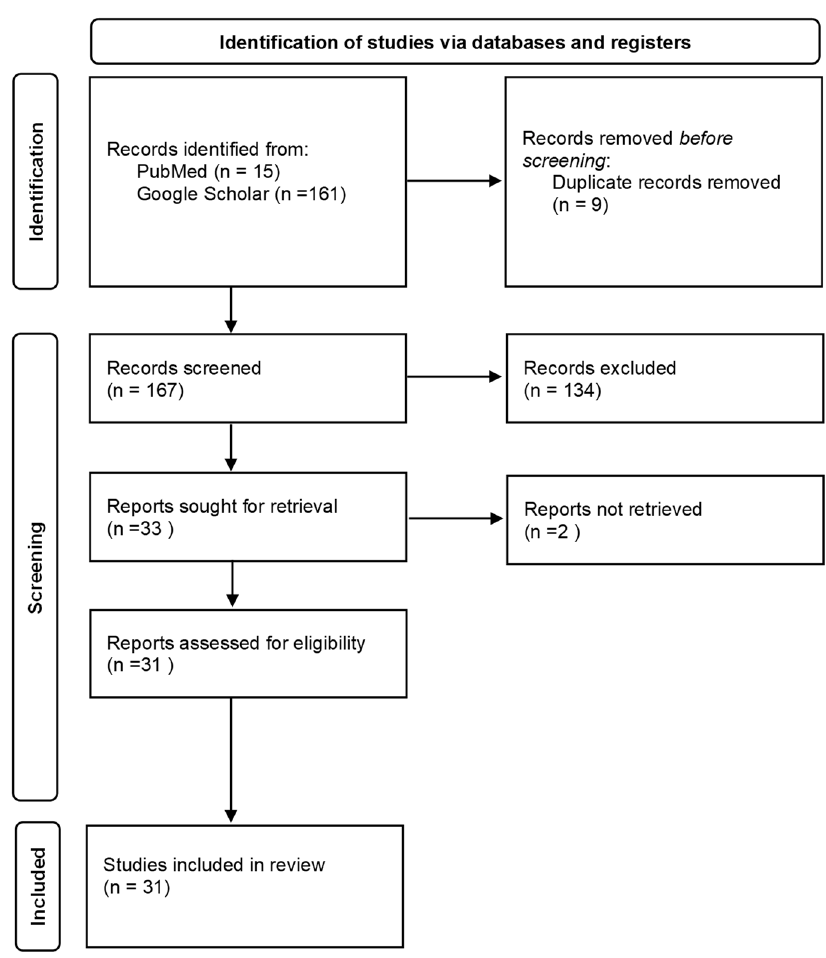
Figure 2. Flow chart of the selection process [35].